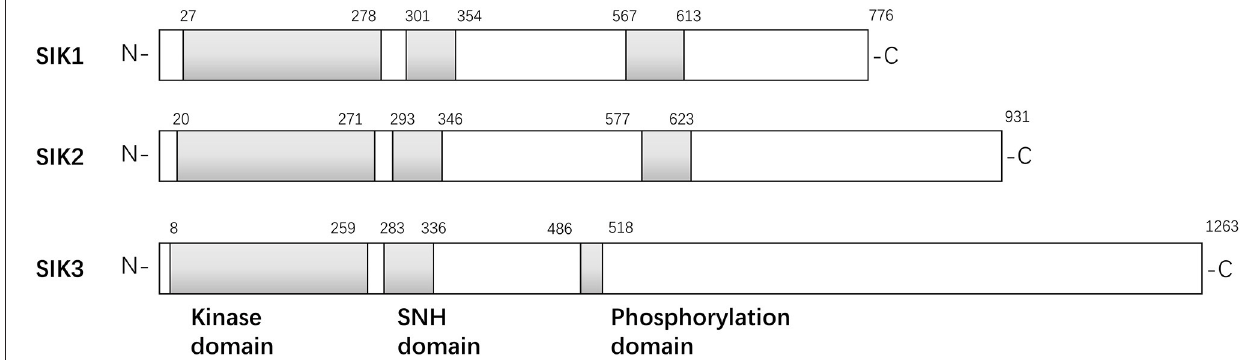
block the downstream pro-growth transcriptional co-activator Yorkie (Yki), which is homologous to mammalian Yes-associated protein (YAP), and exert its regulatory effects on organ size, cell proliferation, and apoptosis during organ development (24, 25).